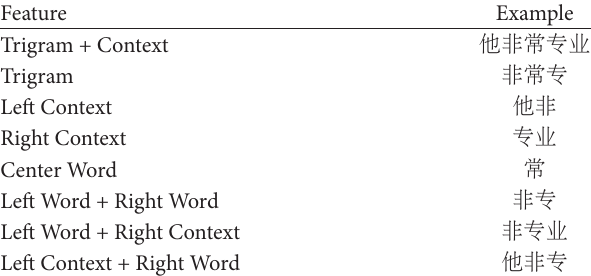
Table 2: Features employed to measure the similarity between two vertices, in a given text example “ 他 非 常 专业 ” (I am very happy), where the trigram is “ 非 常 专